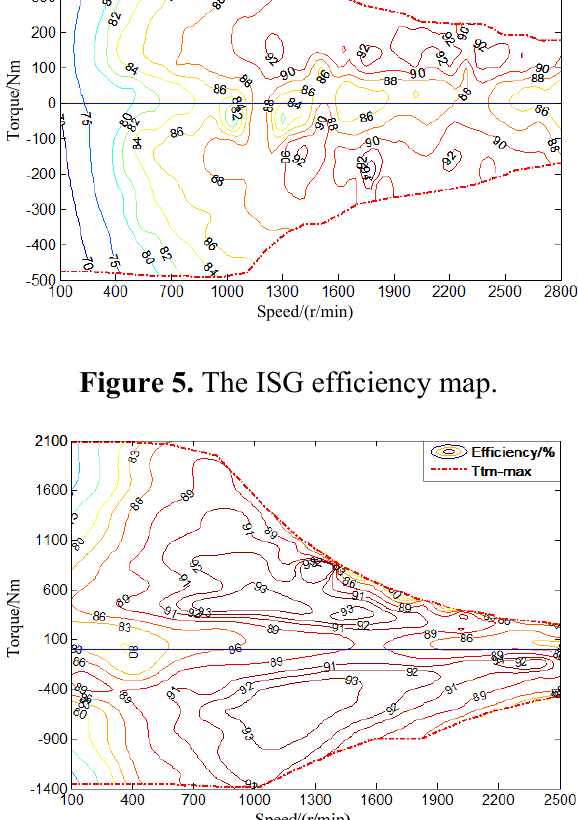
Figure 6. The traction motor efficiency map.